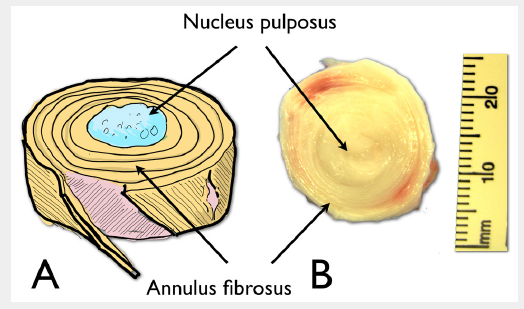
A. Overview of the IVD. Schematic view of nucleus pulposus and annulus fibrosus. B. Transverse view onto fresh-cut caudal bovine intervertebral disc (animal aged ~1 year). The two tissue types can be clearly distinguished